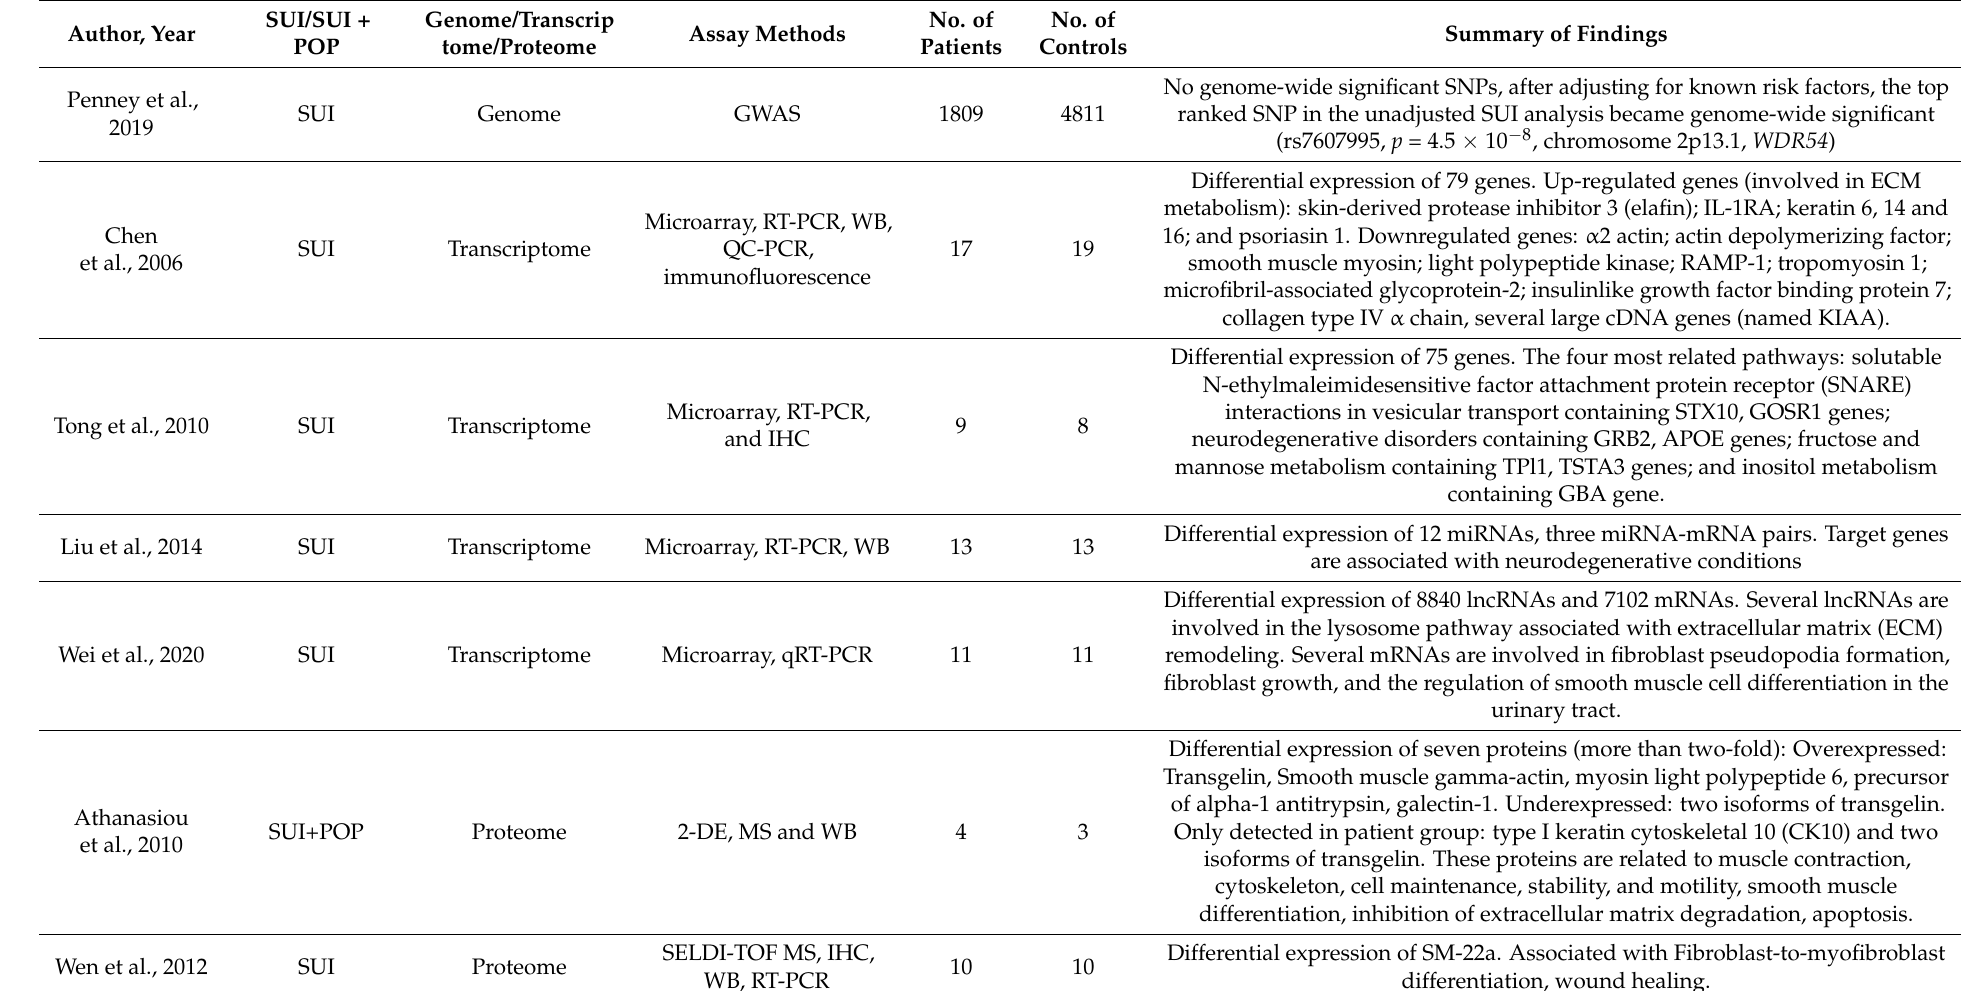
Table 1. Human studies with hypothesis-free